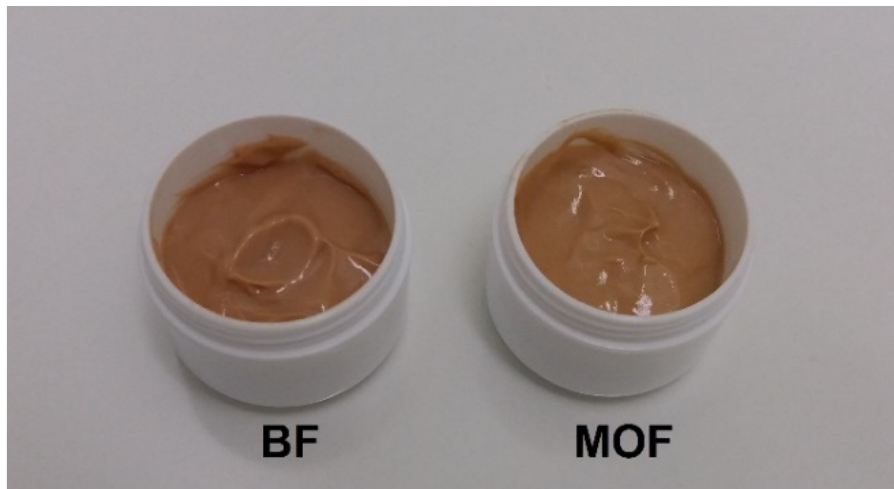
Figure 1. Images of the cosmeceutical formulations developed: base formulation (BF) and formulation with microcapsules of coffee oil (MOF).